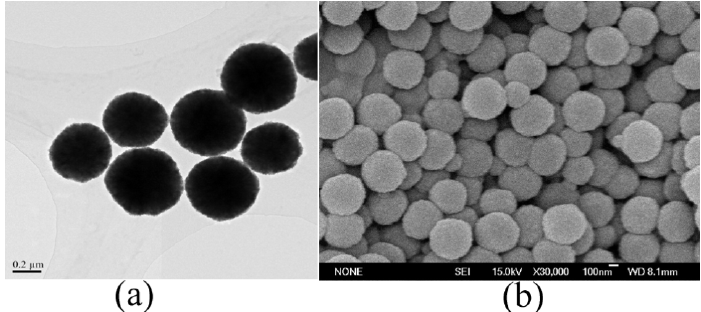
Figure 1. ( a ) Transmission electron microscope (TEM) and ( b ) Scanning electron microscope (SEM) images of the Fe3O4 nanoparticles.